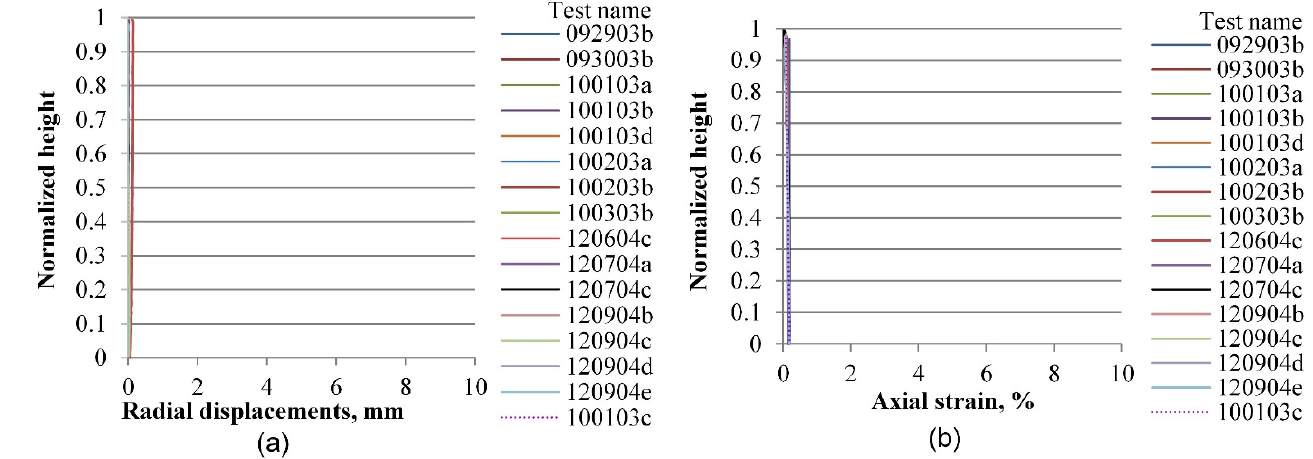
Figure 19. Vertical profiles of averaged displacements at 0.2% of the axial strain of sand specimens prepared by the vibratory compaction method: radial displacements ( a ) and vertical displacements